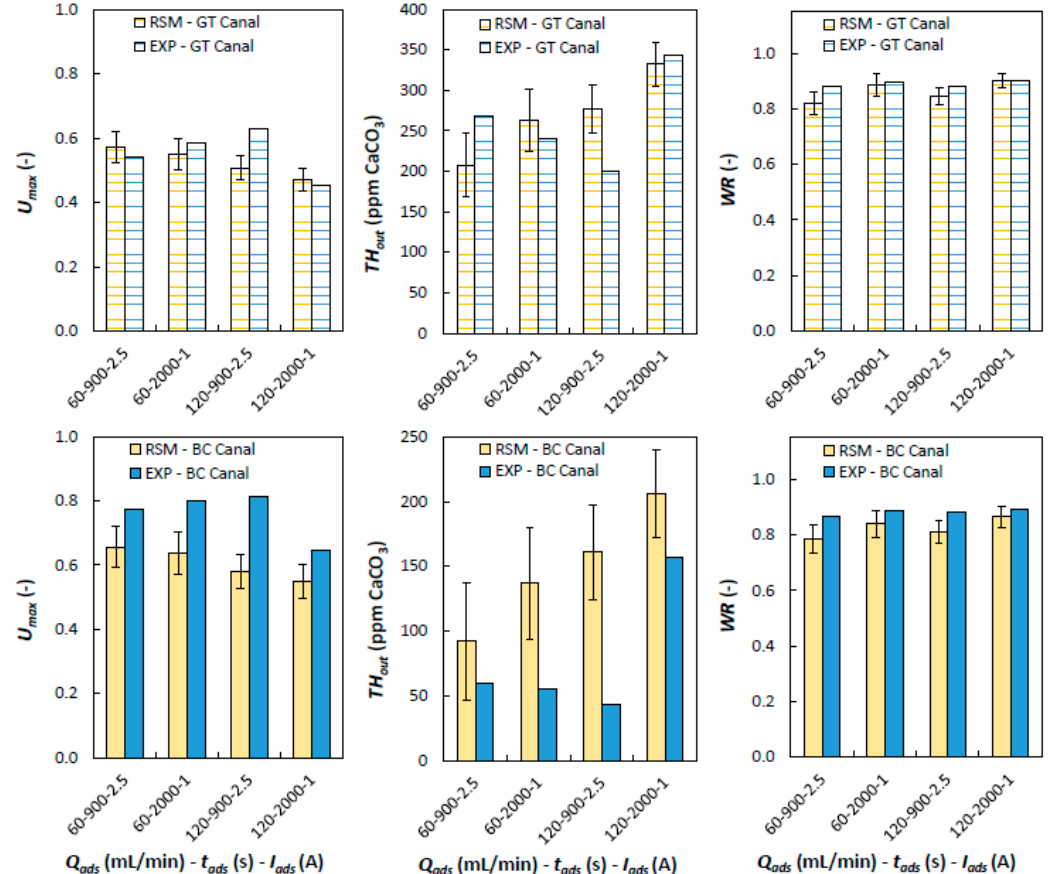
Figure 4. Comparison of U max , WR and TH out derived from RSM (±95% CI) and experimental values for GT Canal ( Top ) and GT Canal ( Bottom ) feed water.